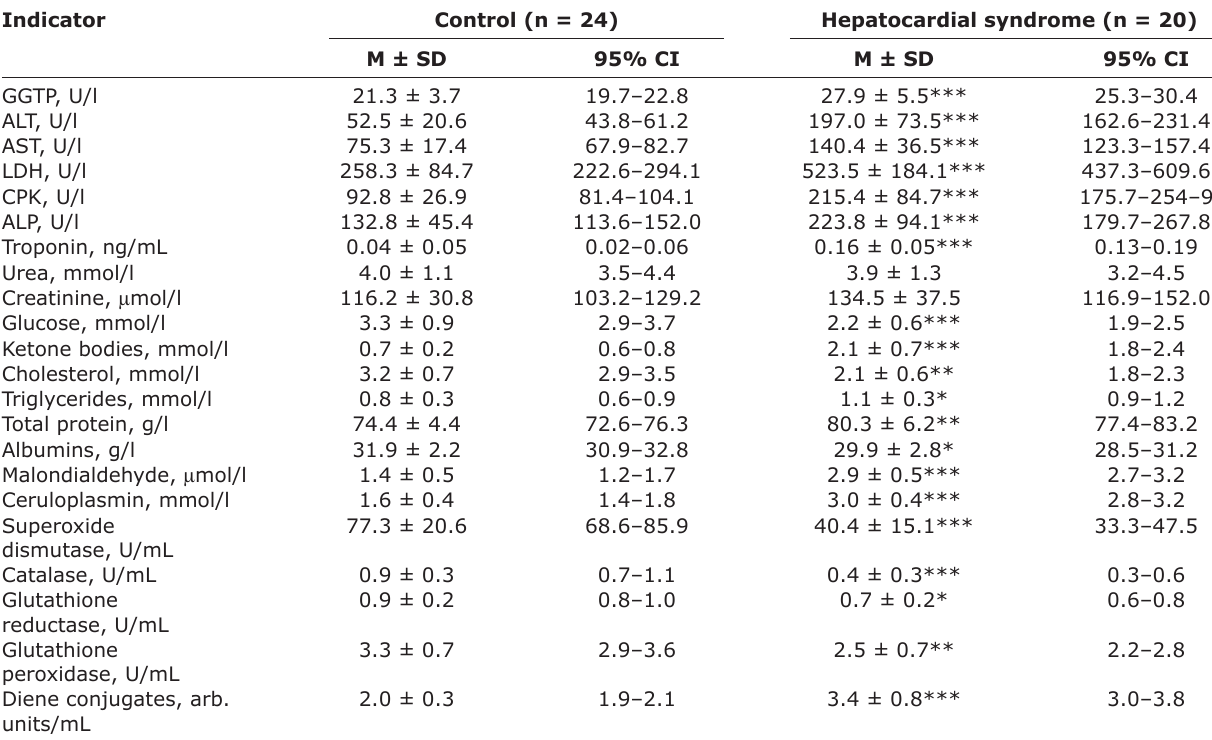
Table-4: Biochemical parameters of blood serum in cows with hepatocardial syndrome. Indicator